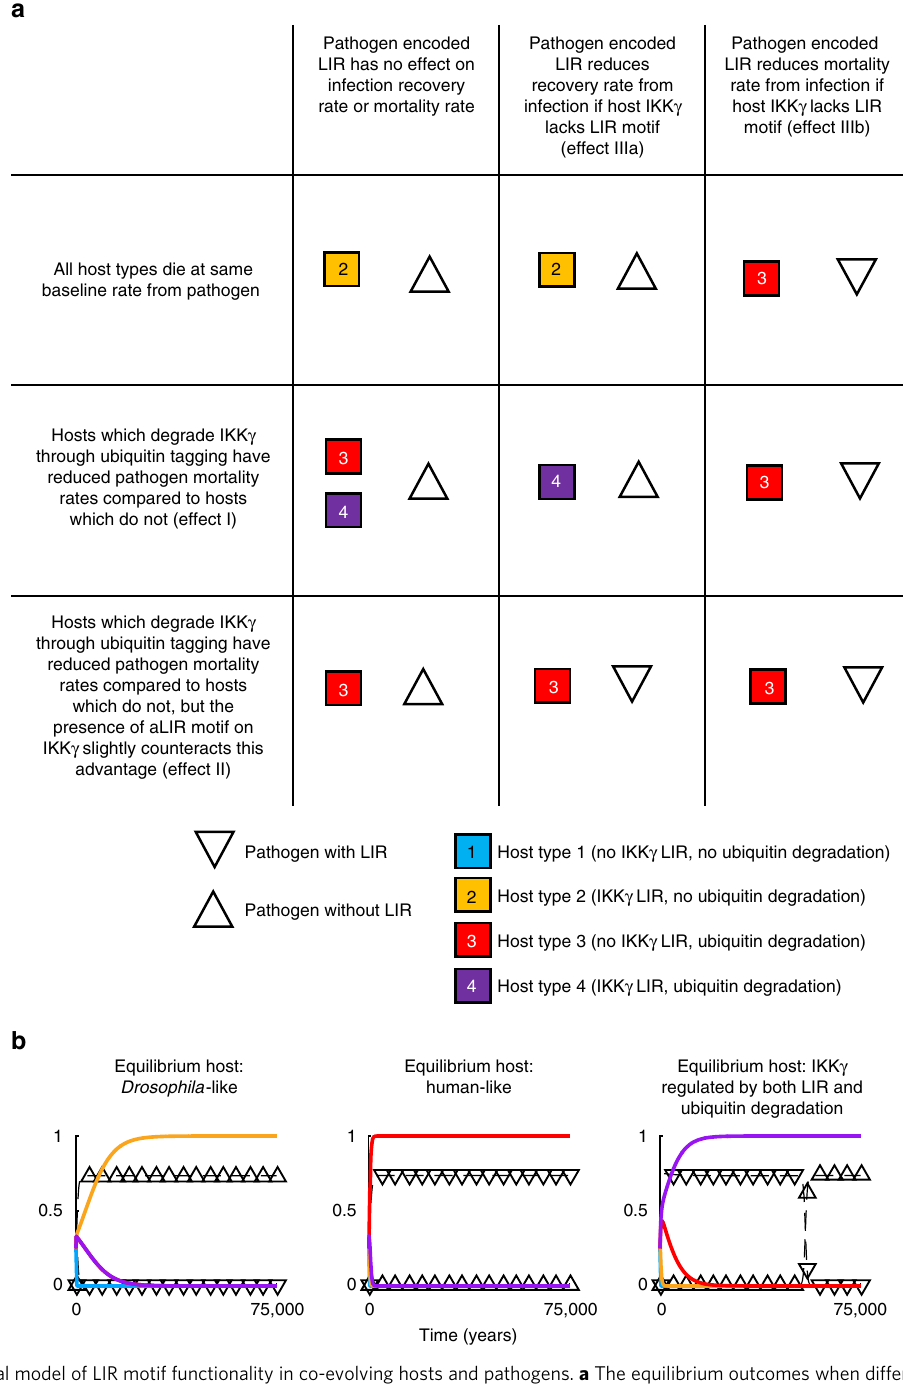
Fig. 9 A mathematical model of LIR motif functionality in co-evolving hosts and pathogens. a The equilibrium outcomes when different assumptions about infection recovery rate and mortality (Effects I – IIIb described in the main text) are applied separately or in combination. The host type(s) present at equilibrium are indicated by the different colored and numbered squares and the pathogen types by triangles. An upright triangle indicates the pathogen circulating at equilibrium can express a LIR motif, a downturned triangle indicates the pathogen does not express a LIR motif. For a description of the model and all parameter values, see Methods section and Supplementary Table 5. b Time series showing the dynamics leading up to equilibrium under three different sets of conditions: applying none of the effects in the main text, resulting in a Drosophila – like scenario; applying Effects I and IIIb leading to a human-like host and a LIR expressing pathogen at equilibrium; and applying Effects I and IIIa, leading to an equilibrium population where host IKK γ is regulated by both LIR and ubiquitin degradation. The different colored lines show the proportion of the host population belonging to a particular host type and the triangular markers indicate the proportion of the population infected with a pathogen that can express LIR (downturned triangle) or a pathogen that cannot express LIR (upturned